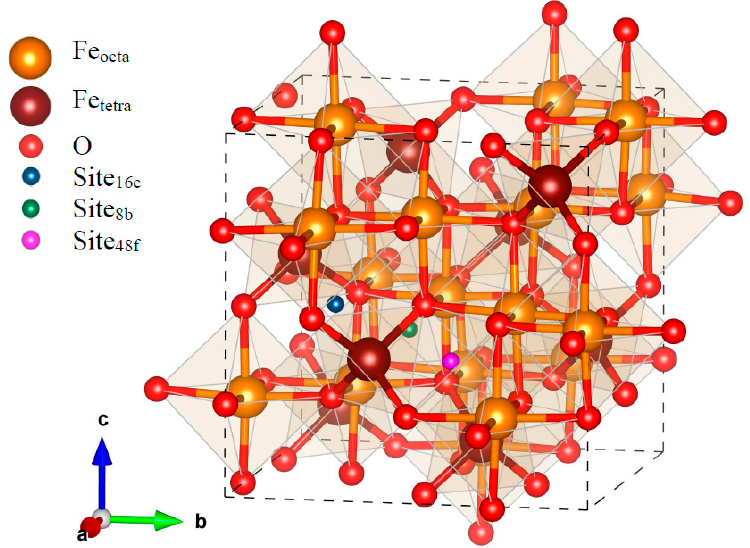
Figure 1. Magnetite unit-cell used in this study for DFT calculations, with the three possible He insertion sites (16c, 8b and 48f).